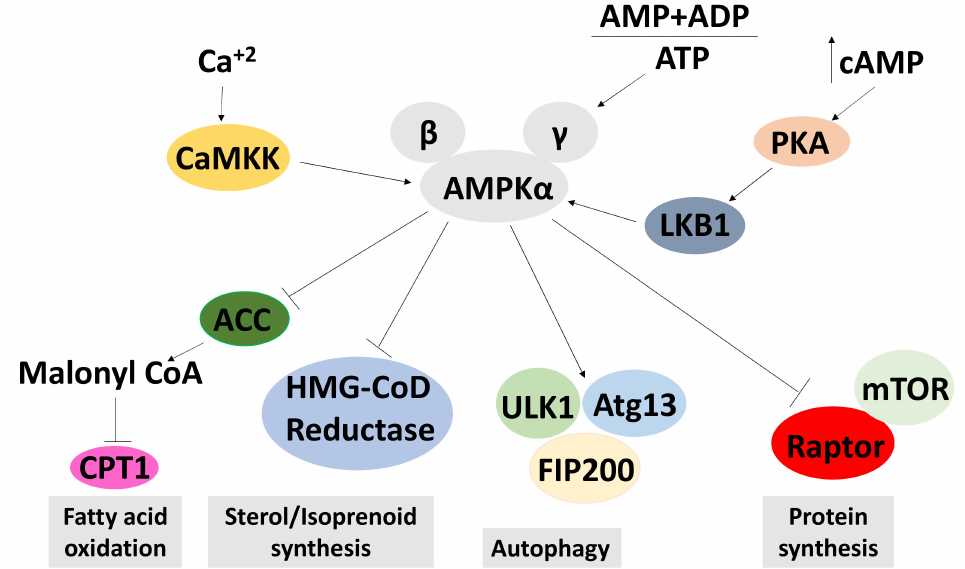
Figure 6. A schematic model of the AMPK signalling pathways. This model shows the activation of AMPK in response to low adenosine triphosphate (ATP) levels, and an increased adenosine diphosphate (ADP) and adenosine monophosphate (AMP). As a result, it activates pathways that produce ATP, thus increasing ATP levels. Conversely, pathways that deplete ATP are repressed by AMPK. AMPK is activated by an increased AMP + ADP to ATP ratio and phosphorylation by CAMKK or LKB1. Activated AMPK inhibits acetyl-CoA carboxylase (ACC), HMG-CoD reductase and mTORC1, leading to an increase of fatty acid oxidation and a reduction in sterol and protein synthesis. Active AMPK inhibits autophagy. An arrow indicates an upregulation of the process and a T end represents a downregulation of the process.